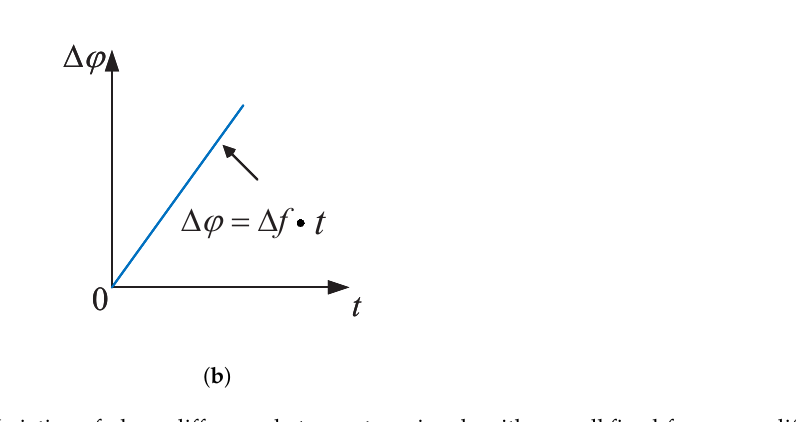
Figure 4. Variation of phase difference between two signals with a small fixed-frequency difference: ( a ) Schematic diagram of the relationship between the phase difference and time. ( b ) Schematic diagram of phase–frequency mapping.